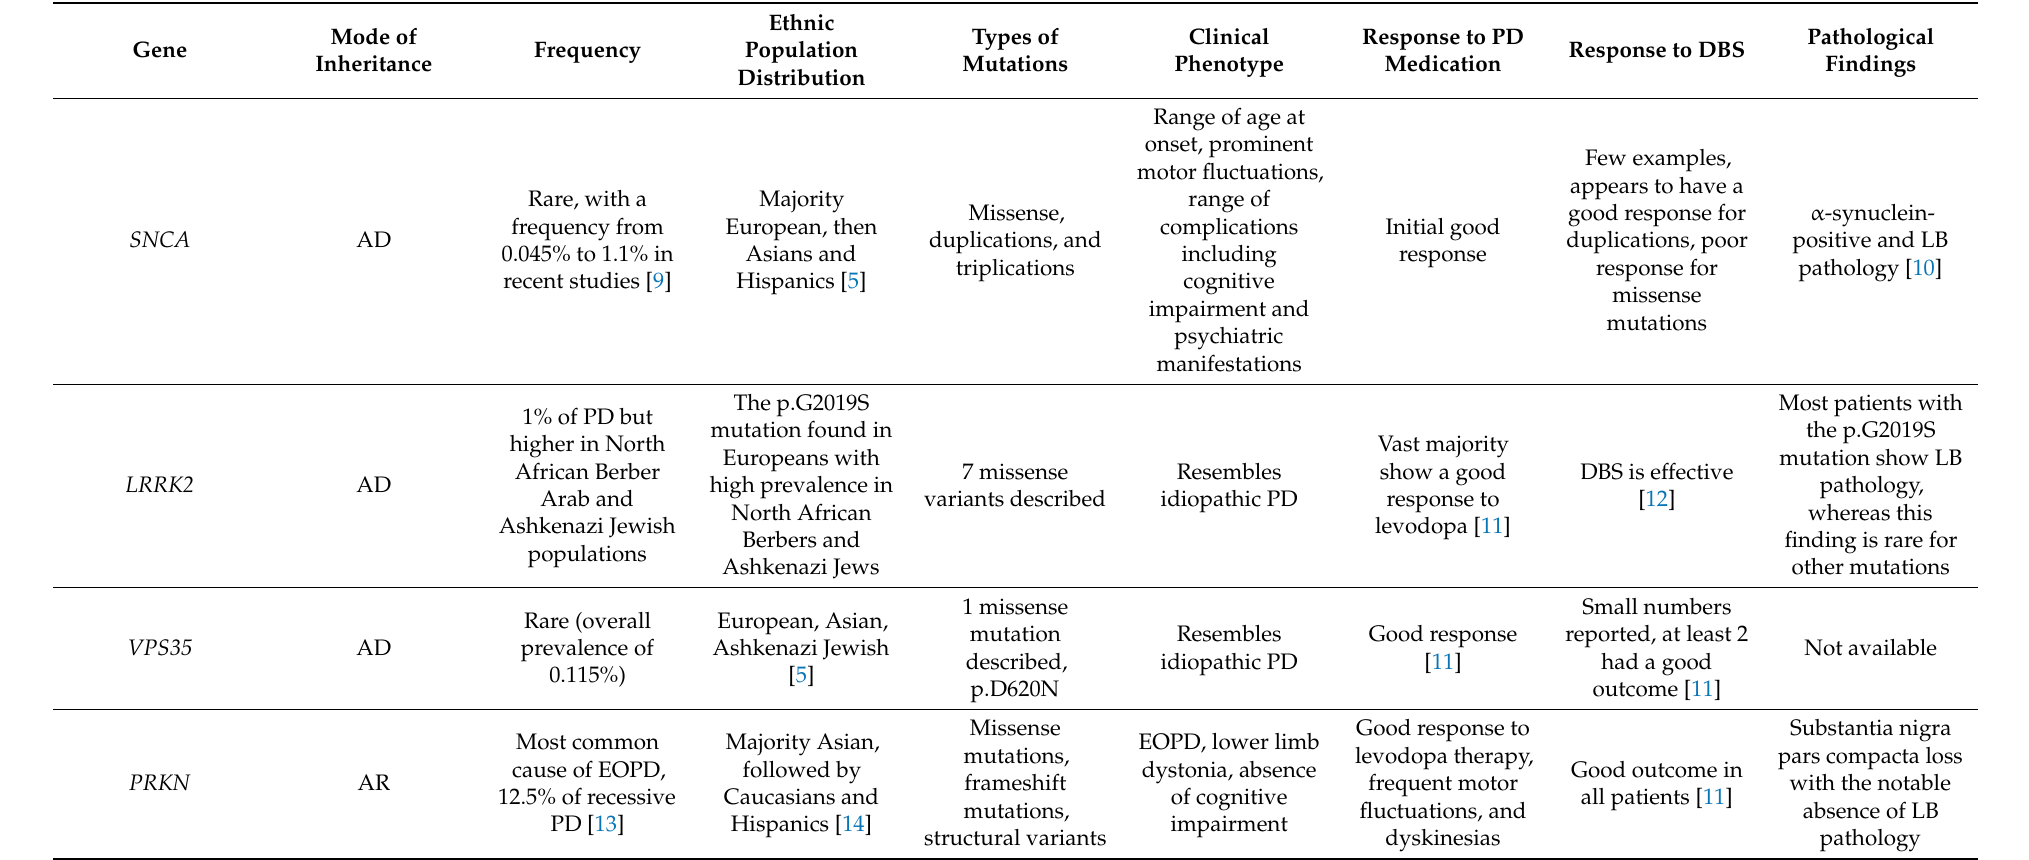
Table 1. Genotype-phenotype summary for monogenic forms of Parkinson’s